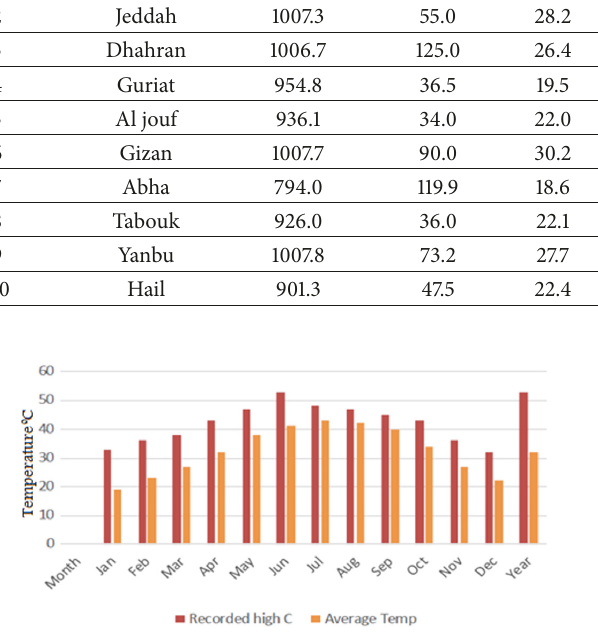
Figure 1: Temperature data for Riyadh, Saudi Arabia [8].